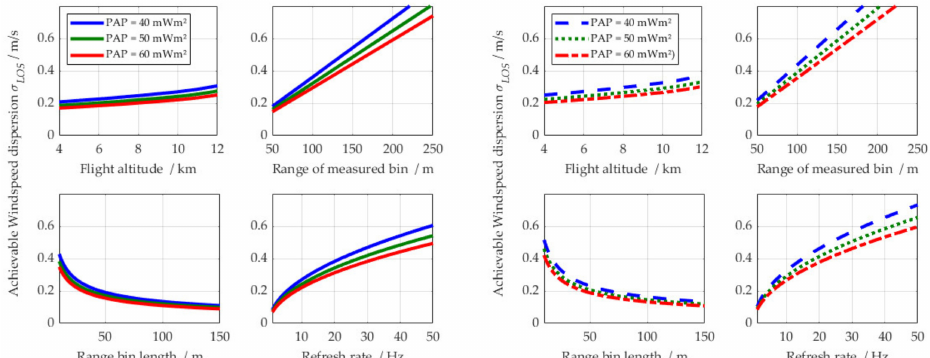
Figure 1. ( Left ) panels show the dependencies of Equation (8) on variables for altitude h , range of measurement R , range resolution (or bin length, or range gate length) ∆ R and (averaging) refresh rate r refresh . ( Right ) panels show the same dependencies when (analytically) incorporating electronics noise terms into Equation (8), which is not further addressed